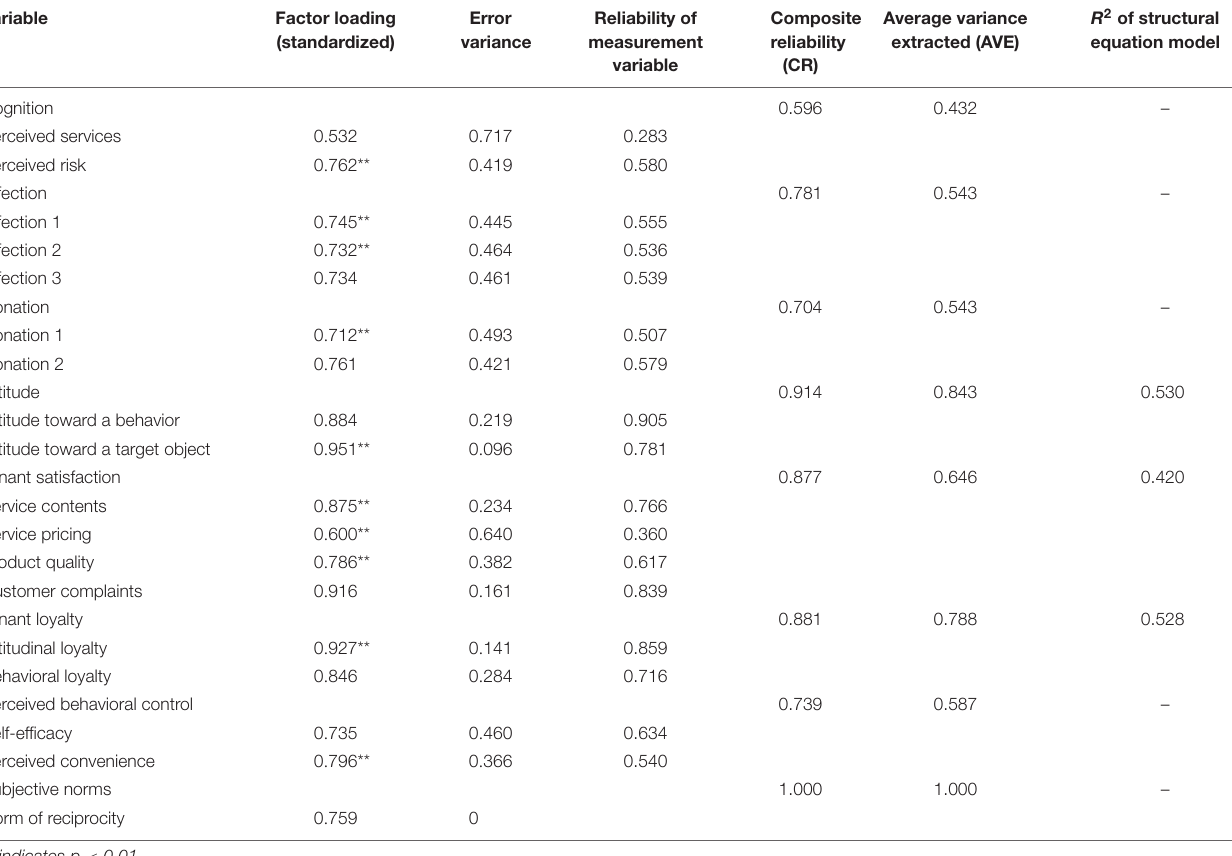
TABLE 2 | Analysis of the reliability, factor loading, and average variance extracted of the scale.